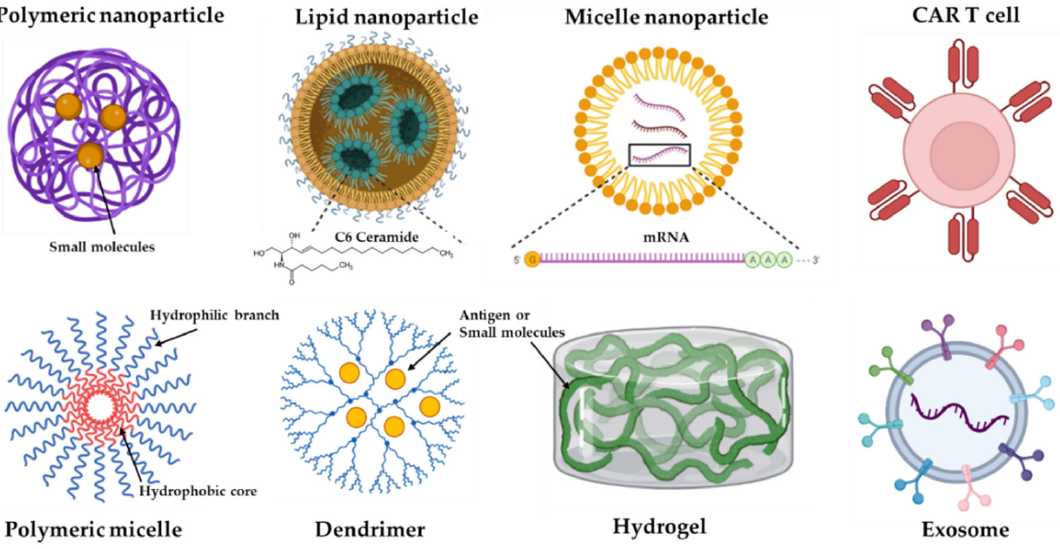
Figure 2. Some representative formats of immunotherapy delivery systems. Nanoparticles (NPs) can be formed by different materials, including iron (e.g., gold), lipid, polymeric, and self-format- ting NPs.